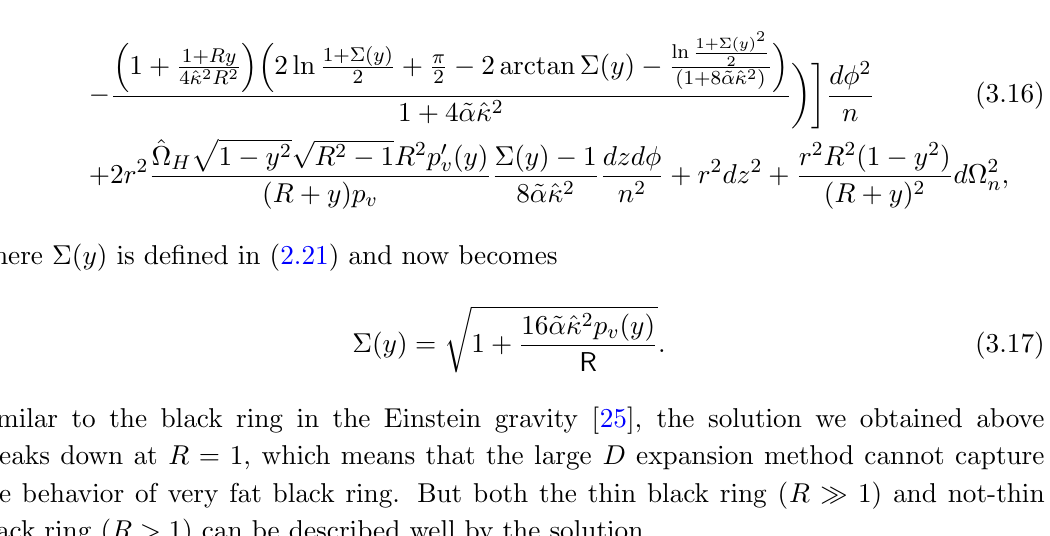
Figure 2 . The ( j; s ) phase diagrams of the large D EGB black ring solution for n = 30 ( D = 34). The ring radius R runs from 1 : 1 to 20, so both the not-thin region and thin region ( R (cid:29) 1) are